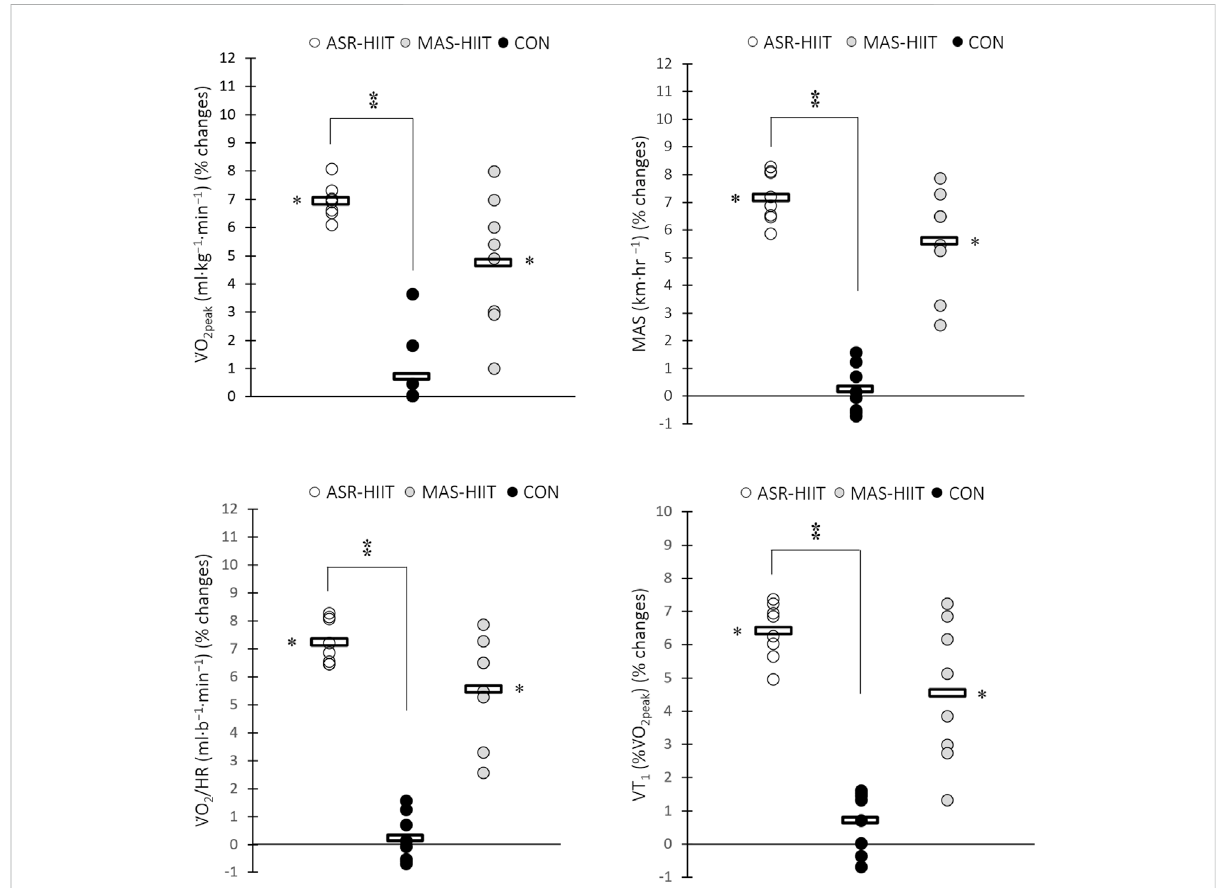
FIGURE 2 Effects of ASR-based HIIT (ASR-HIIT), HIIT based on the MAS (MAS-HIIT), and traditional endurance paddling (CON) on changes in V _ O 2peak , maximal aerobic speed (MAS), V _ O 2 /HR,and ventilatory threshold[VT 1 (%V _ O 2peak )]. Circlesindicate individual percent changes frombaseline(X-axes) andhorizontalbarsrepresentthegroupmeanresponse. N=8foreachgroup. *Denotessigni fi cantdifferencevs.pre-training( p ≤ 0.05). ⁑ Denotes signi fi cant difference vs. CON group ( p ≤